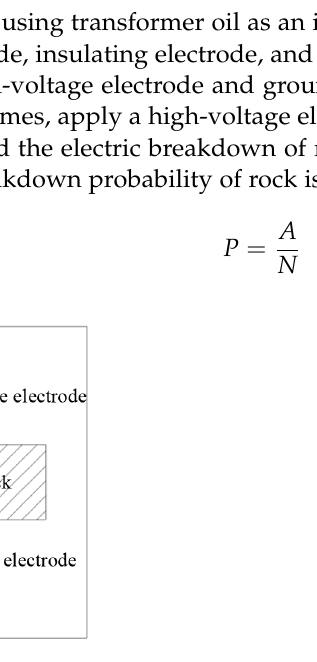
Figure 19. Schematic diagram of rock breakdown in transformer oil.